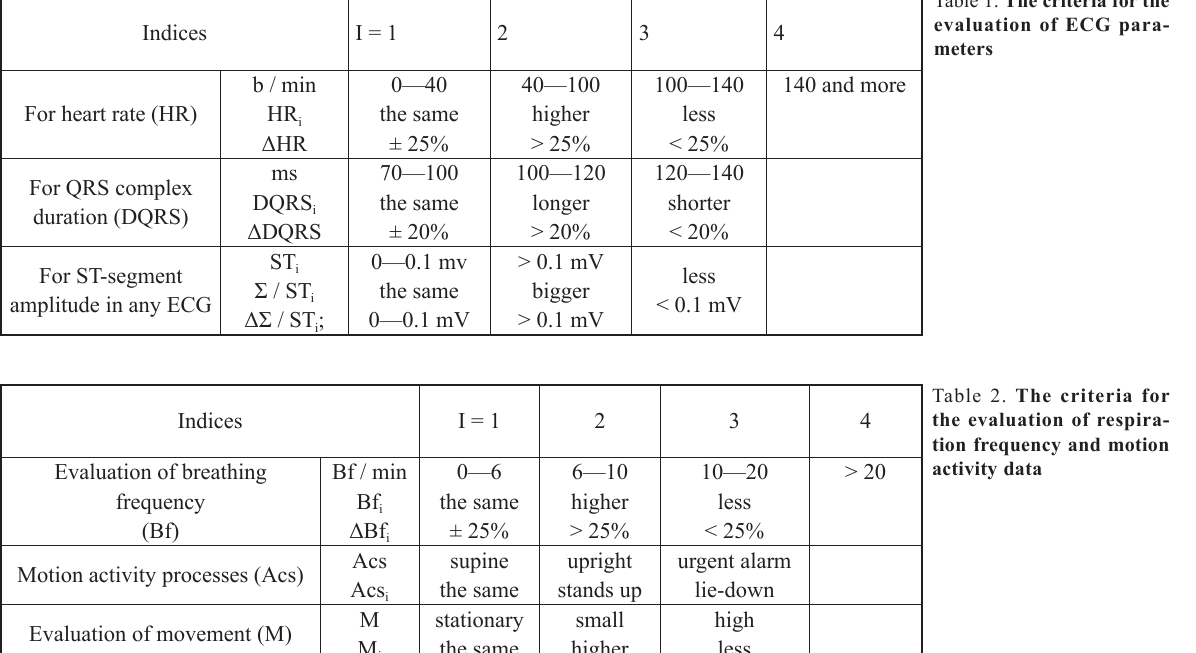
Table 2. The criteria for the evaluation of